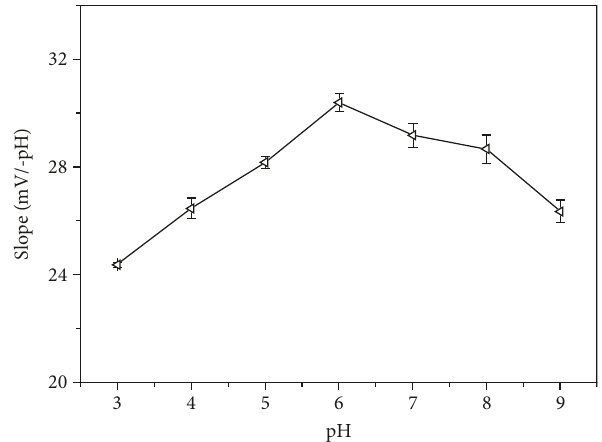
Figure 5: Effect of pH on the sensitivity of the GPE/COF